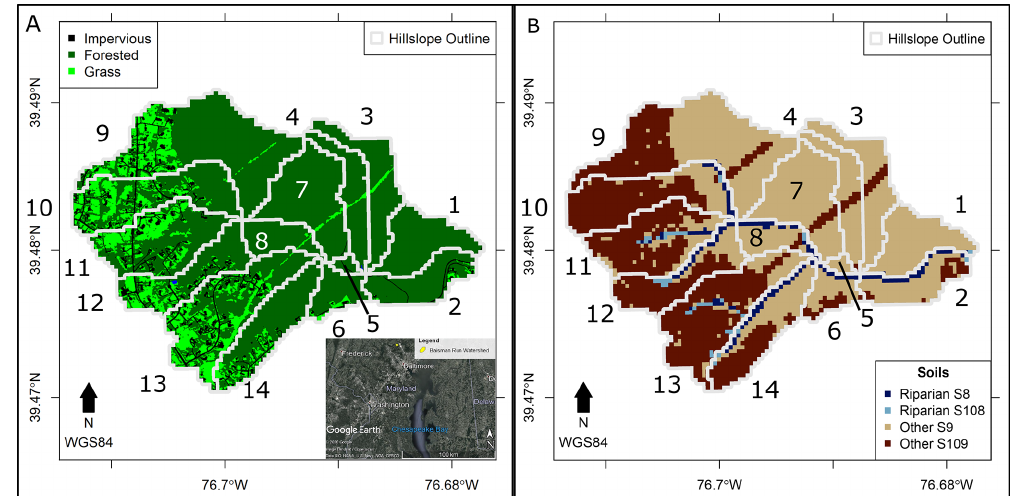
Figure 1. (a) Land cover of the Baisman Run watershed (data provided by Chesapeake Conservancy, 2014), and an inset map showing the location in the USA (Google Earth, 2020). Numbered hillslopes are outlined in gray. (b) Soil types of Baisman Run (data provided by United States Department of Agriculture (USDA), 2017). Compacted soils begin with S10.